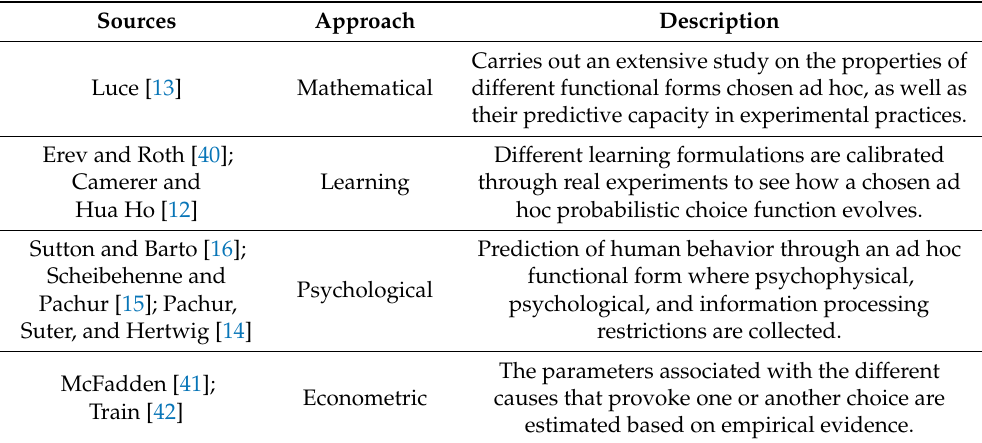
Table 1. Research lines that use the logistic functional